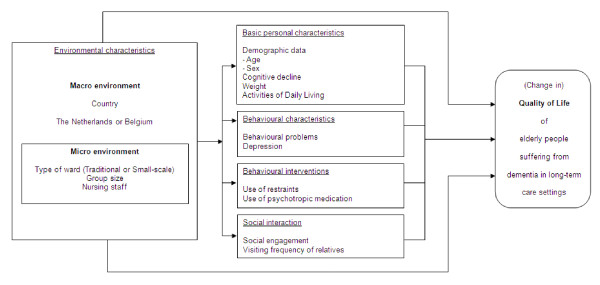
Conceptual Model.